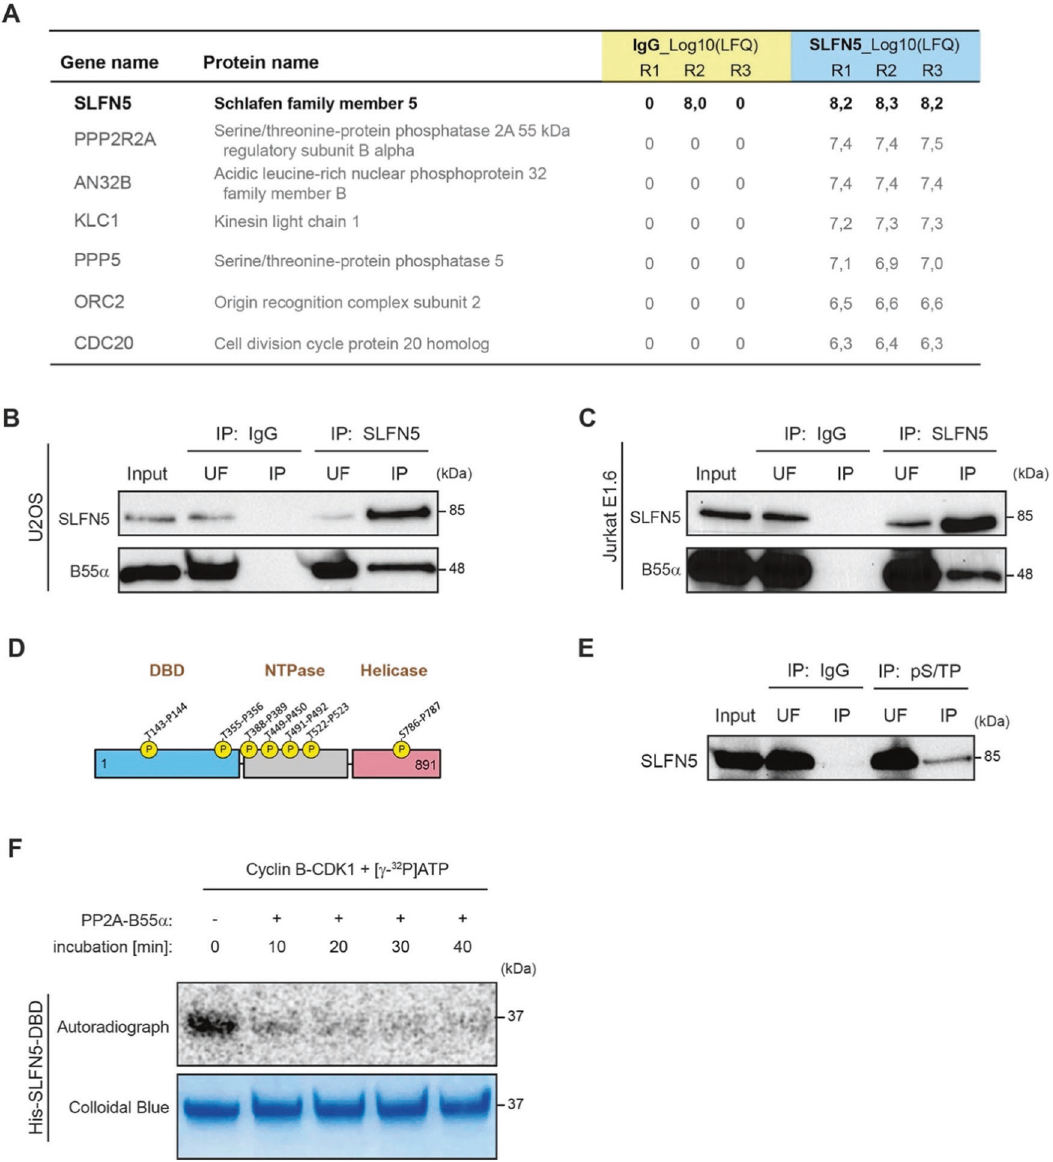
Fig. 2 PP2A-B55 α interacts with SLFN5 and dephosphorylates its CDK minimal consensus sequences. A Table summarizing the strongest interactors identi fi ed by mass spectrometry after SLNF5 immunoprecipitation. For each protein, the log10 values of the label-free quanti fi cation intensities (LFQ) in the three replicates of the IgG-IP and SLNF5-IP are reported. B , C Validation of SLFN5 - B55 α interaction in U2OS and Jurkat E1.6 cells by co-immunoprecipitation followed by Western blotting. #112/5/6 anti-SLFN5 was used to co-immunoprecipitate endogenous SLFN5 and its interactors. Immunoprecipitation with an irrelevant mouse IgG antibody served as a negative control (control IP). B55 α recovery was con fi rmed using an antibody against the regulatory subunit B55 α . UF, unbound fraction. The Western blot shows a representative experiment from three independent validations. D SLFN5 contains a cluster of fi ve TP motifs in the DBD and NTPase domain, and single TP (T143-P144) and SP (S786-P787) motifs at the N-terminus and C-terminus, respectively. E SLFN5 is phosphorylated at T/SP minimal CDK consensus sequences. An anti-pT/SP antibody was used for immunoprecipitation in U2OS cells. The membrane was probed with #112/5/6 anti-SLFN5. Immunoprecipitation with an irrelevant mouse IgG antibody served as a negative control. The Western blot shows a representative experiment from three independent experiments. F SLFN5-DBD TP sites are phosphorylated by Cyclin B-CDK1 and dephosphorylated by PP2A-B55 α . Timecourse of SLFN5-DBD dephosphorylation. Comassie staining serves as loading control. The Radiograph shows a representative experiment from three independent holoenzyme [18]. For the B55 regulatory subunit it was shown that basic residues fl anking a minimal CDK consensus sequence